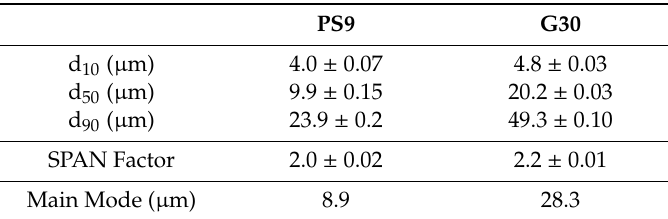
Table 4. Statistical particle diameters, SPAN factor (average ± s.d.; n = 3) and main modes of PS9 and G30 clay